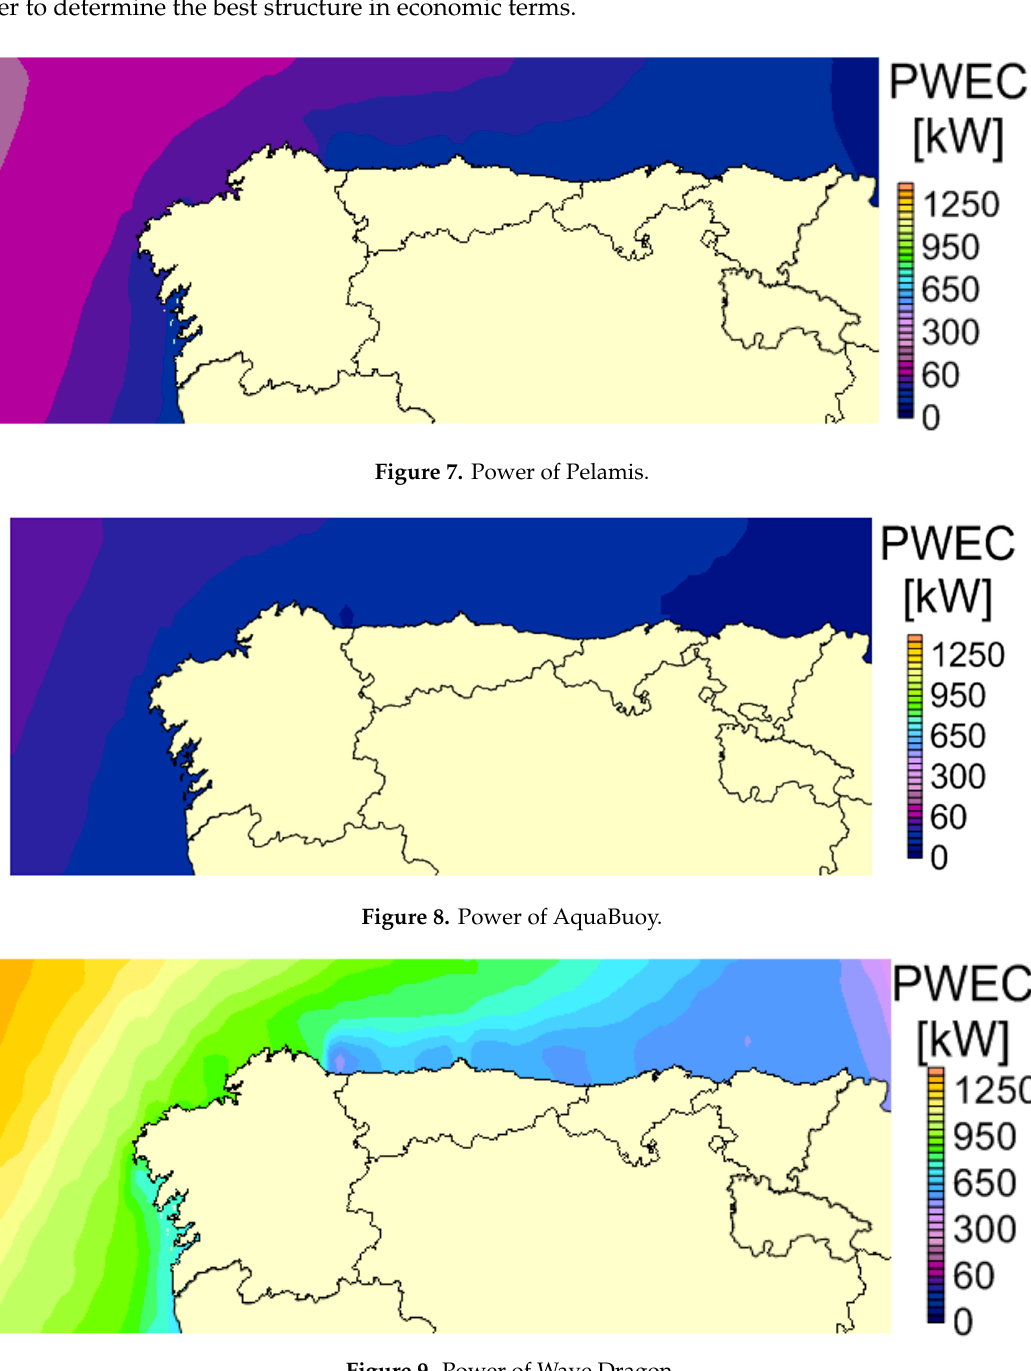
Figure 9. Power of Wave Dragon.